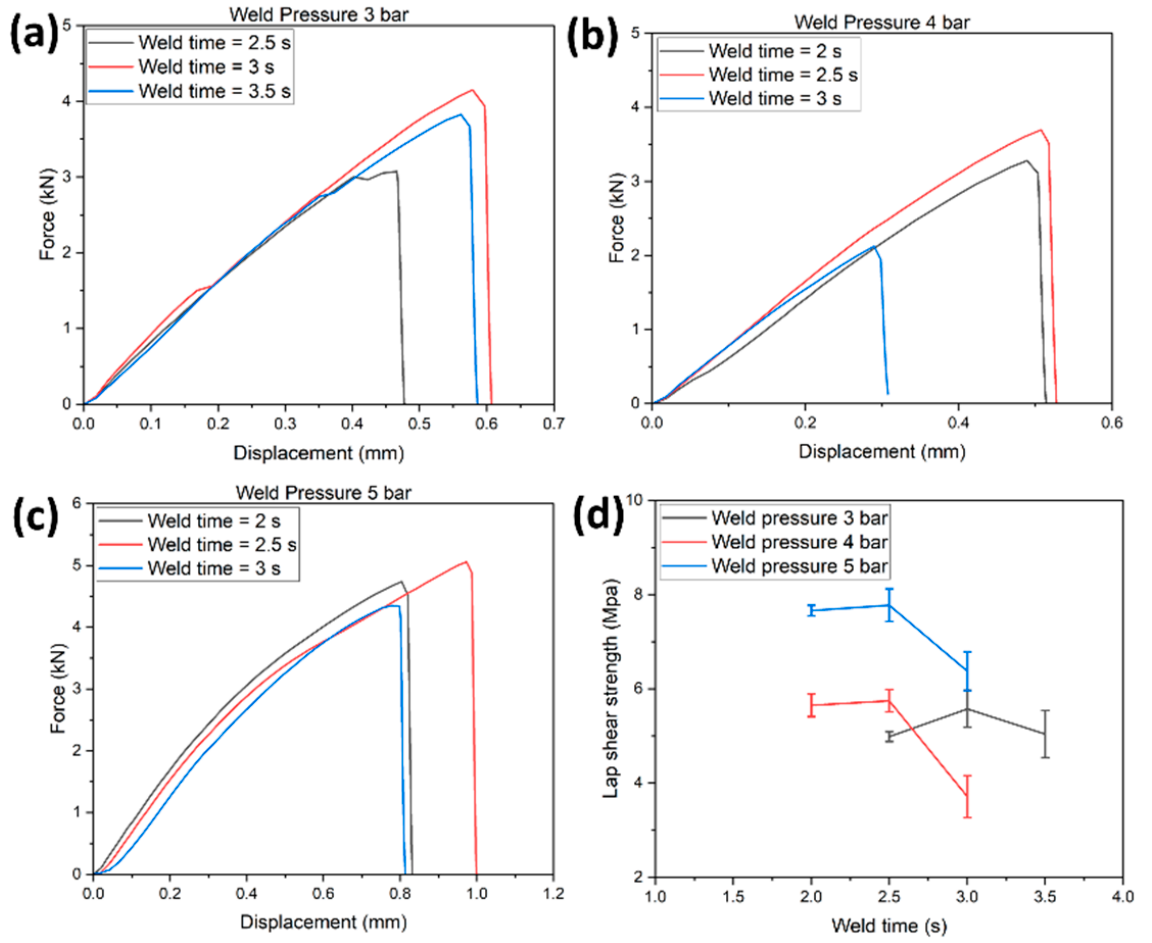
Figure 9. Load-displacement curve for EL-EP(Elium ® -Epoxy)_0.25: ( a ) Weld pressure = 3 bar, ( b ) Weld pressure = 4 bar, ( c ) Weld pressure = 5 bar. ( d ) Lap shear strength vs. weld